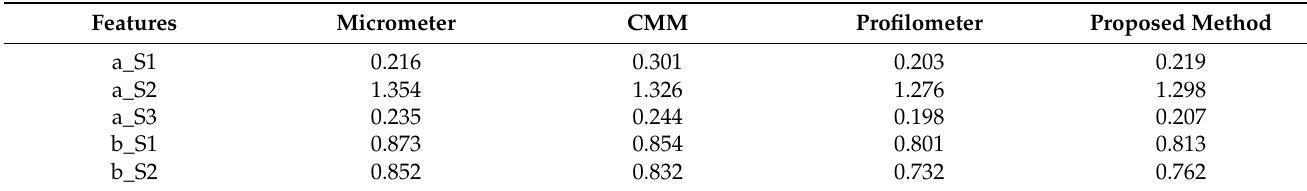
Table 6. Results of comparison with existing methods for roughness